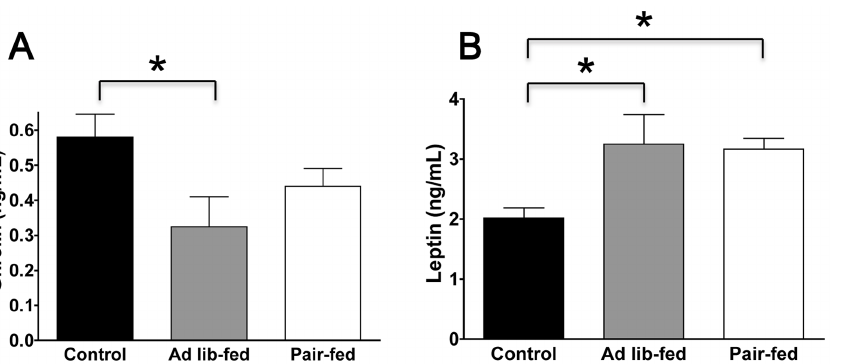
Figure 4. Effect of chronic ICV ghrelin infusion on serum ghrelin (A) and serum leptin (B). Three groups of rats (4–6 per group) were infused for 21 days with saline or ghrelin (1.5 m g/day). Rats infused with ghrelin were ad lib -fed or pair-fed (to saline-infused rats). * P , 0.05. Data are presented as the mean 6 SEM.